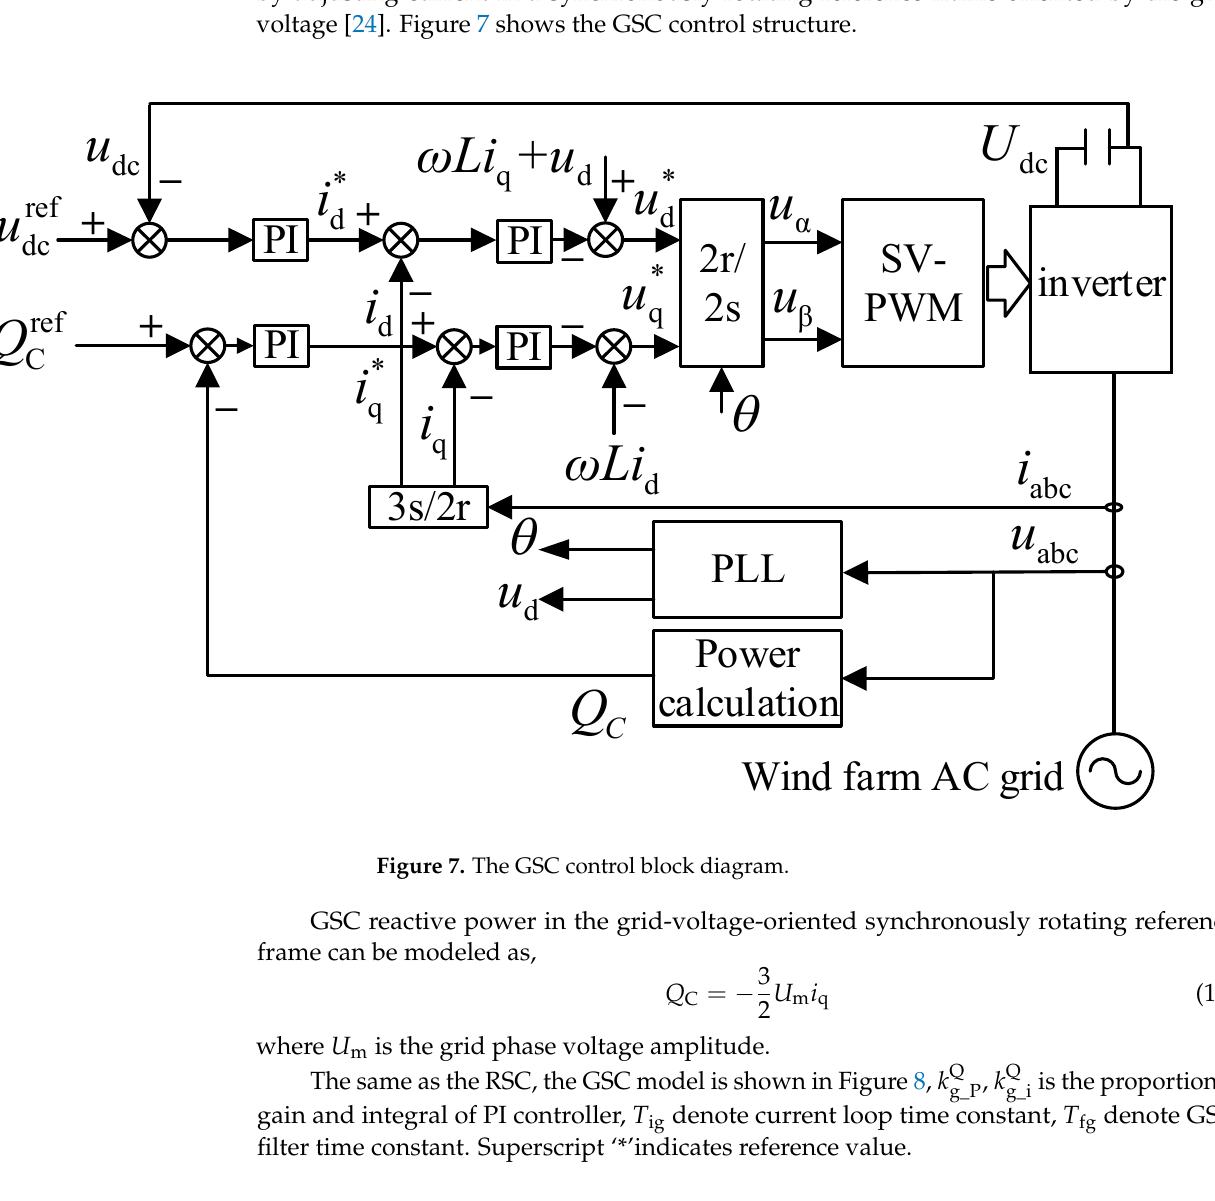
Figure 8. The reactive power control loop of the GSC. Define the Δ i q , Δ Q C , Δ Q ref C , and Δ Q C int are the incremental values between its current value and the initial value at operation point, respectively, and Q C int is the integral of error between Q ref C and Q C . Superscript ‘*’indicates reference value. GSC incremental state space model is derived as follows, ∆(cid:1861) (cid:2927) =